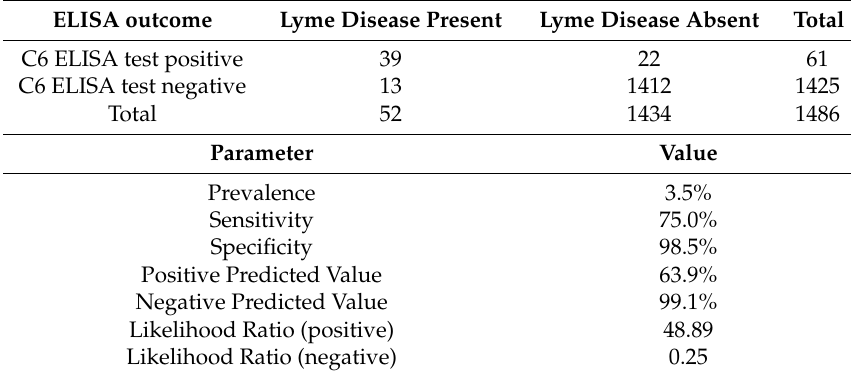
Table 3. Deduced Lyme Disease C6 ELISA test outcomes in New Brunswick in